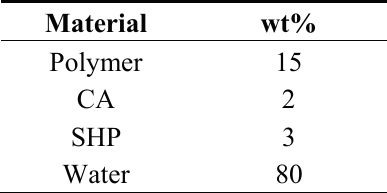
Table 1. Padding formulation.